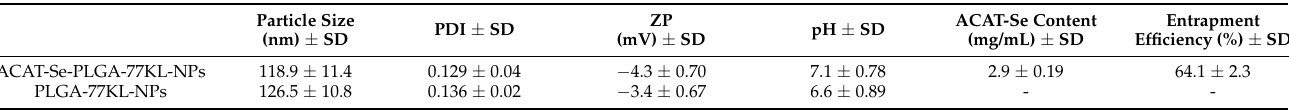
Table 1. Physicochemical characterization of NP suspensions.